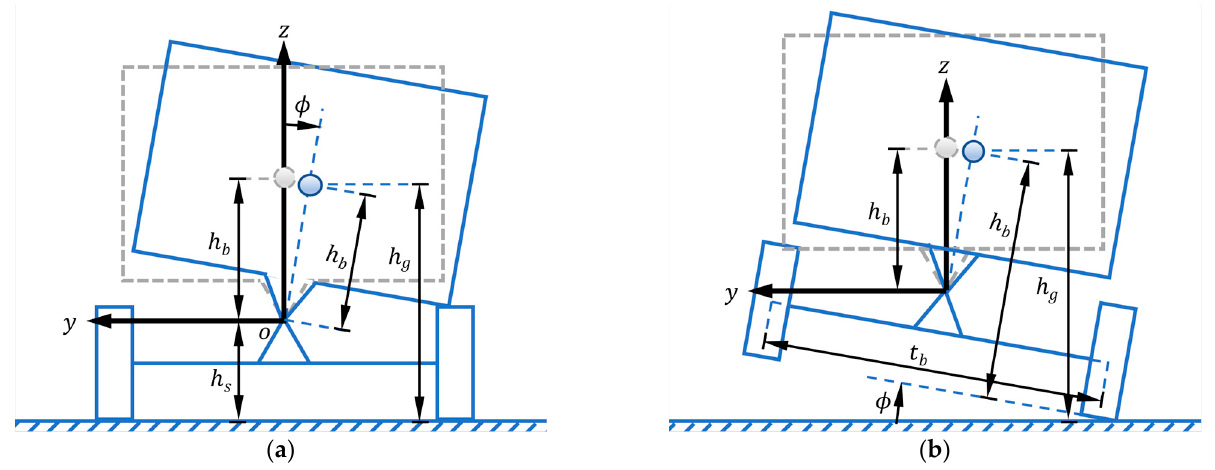
Figure 2. Roll dynamic model should be listed as: ( a ) before wheel lift-off; ( b ) after wheel lift-off. The roll dynamics of the vehicle is represented by two different equations as ex-